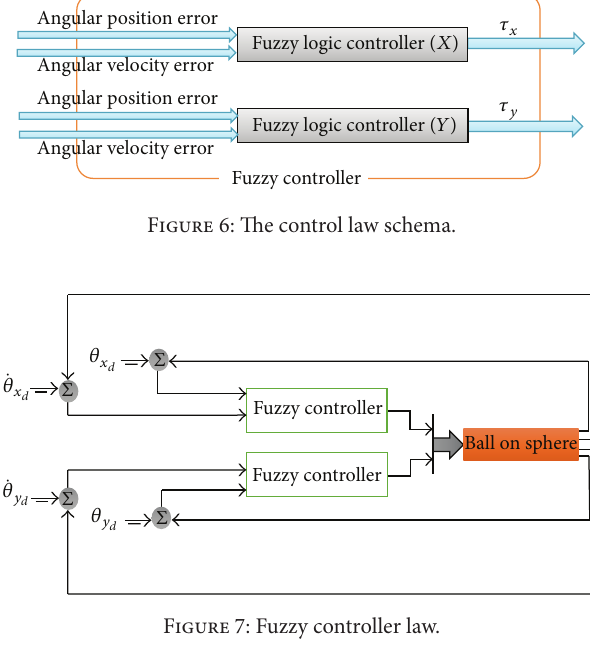
Table 2: Fuzzy rules relation.